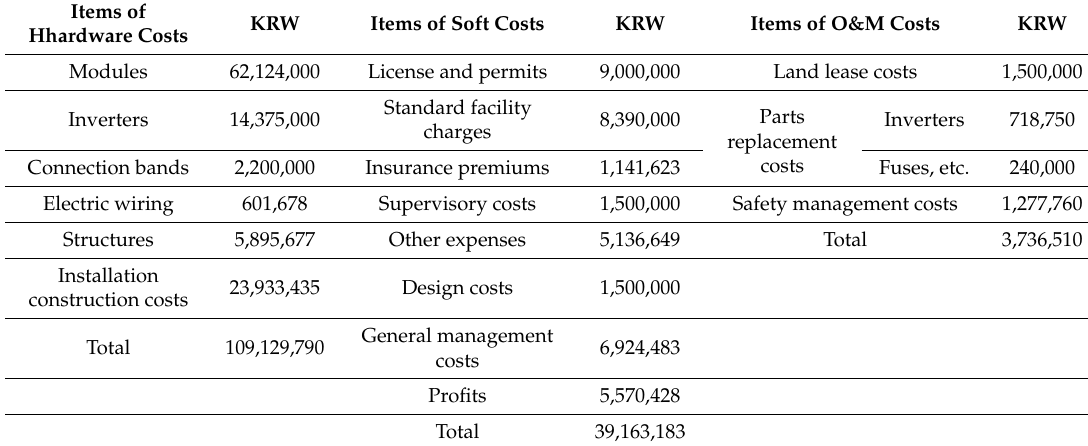
Table 5. Cost breakdown of a 100 kW solar system.